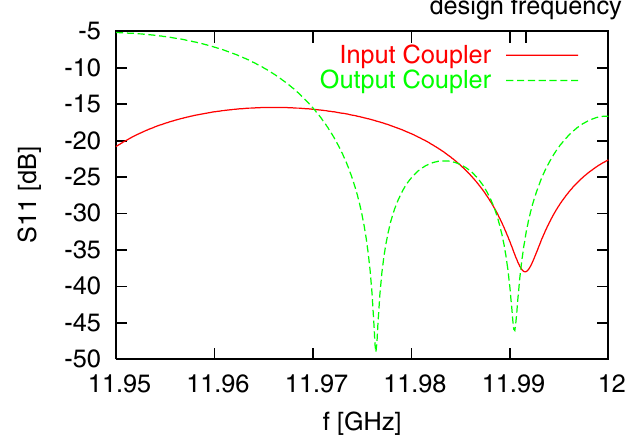
FIG. 4. (Color) Reflection coefficient for the input and output matching cells.